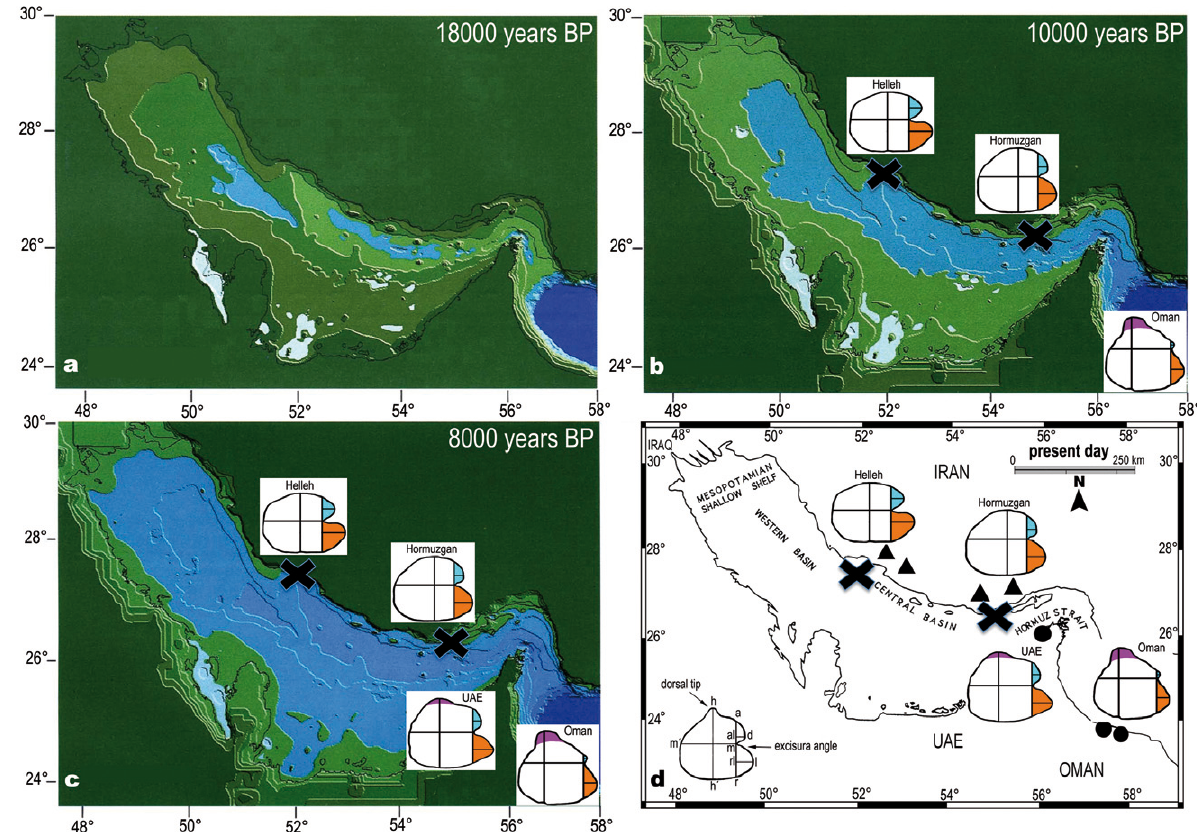
Fig . 5. – Historical zoogeography of Aphanius dispar as indicated by genetically constrained otolith characters. a , subaerially exposed Persian Gulf sea floor during the last glacial maximum of the Late Pleistocene; b-c , Early Holocene re-flooding of the Persian Gulf, black crosses indicating absence of gene flow between A. dispar inland populations and immigrants from the Gulf of Oman; d , present-day situation of the Persian Gulf, circles showing coastal sites, triangles landlocked sites, black crosses absence of gene flow between A. dispar inland populations and coastal A. dispar individuals. Otolith images are representative images of the groupwise registration method; linear distances in otolith images represent selected morphometric distances (see inset in d and Figure 1). Source of maps: Purser and Seibold (1973), Lambeck (1996), Teller et al .